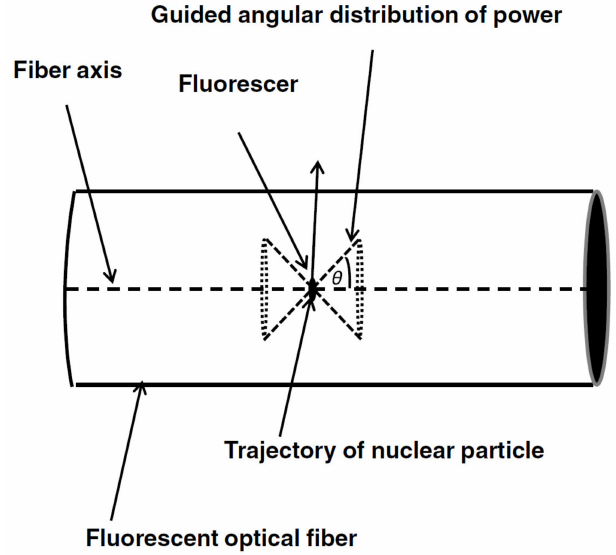
Figure 4. Emission of guided radiation from an on-axis fluorescer within a fluorescent optical fiber. Reproduced with permission [32]. Copyright 2015,